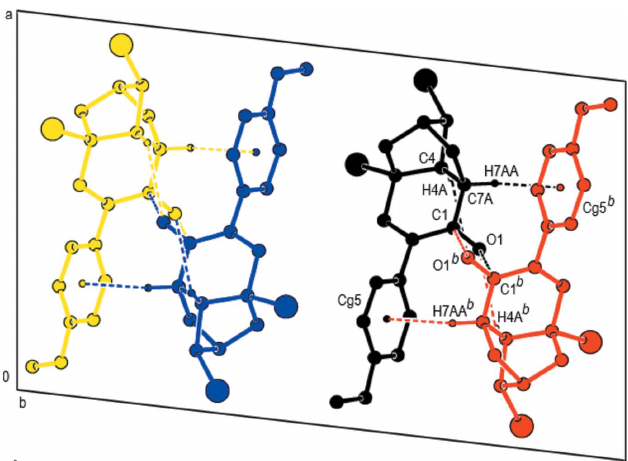
(cid:3) z ; + y , 3 2 2